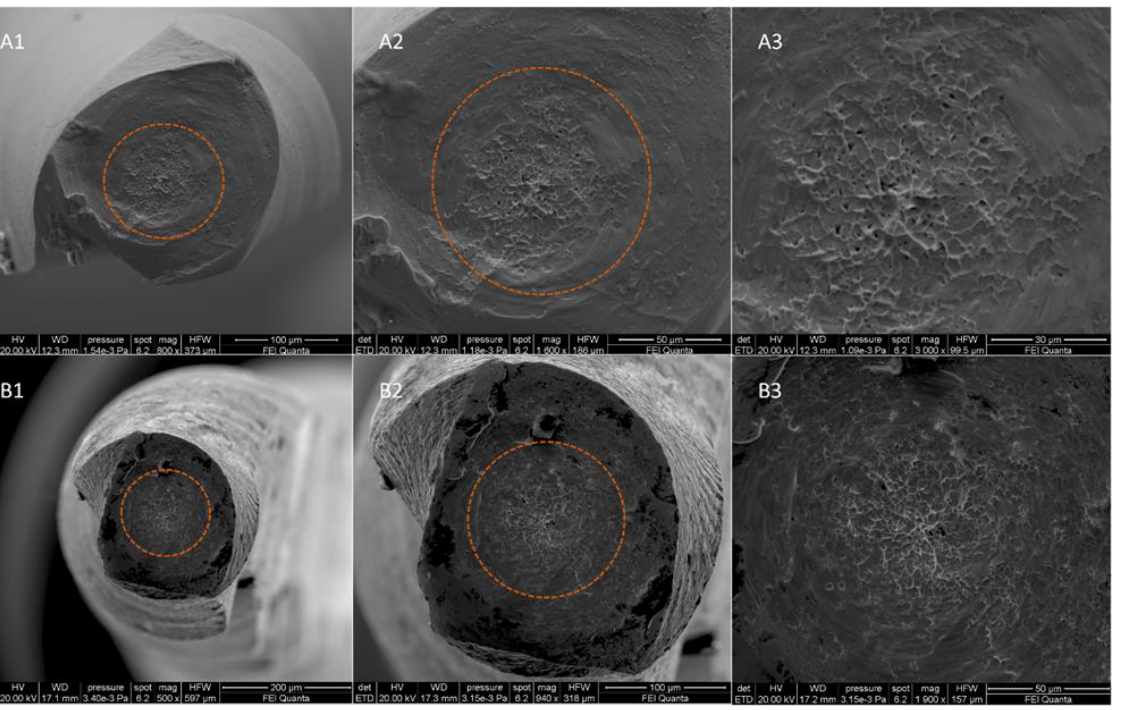
Figure 2. SEM images of fractured surface of two samples of F-One 20.04 in a transversal view at different magnifications after torsional fatigue testing. Images ( A1 – A3 ) represent SEM captures of an austenitic instrument, while images ( B1 – B3 ) represent SEM captures of a martensitic instrument. All acquisition specifications are shown in the black box below each image. The concentric circular abrasion marks and fibrous dimples near the center of rotation are evidenced by the orange circumferential